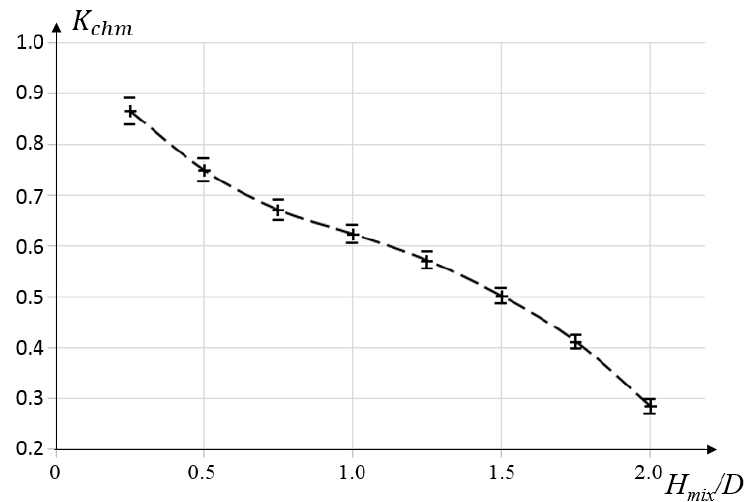
Figure 4. Homogeneity of foam concrete mixture K chm vs. ratio H mix / D (experimental data).